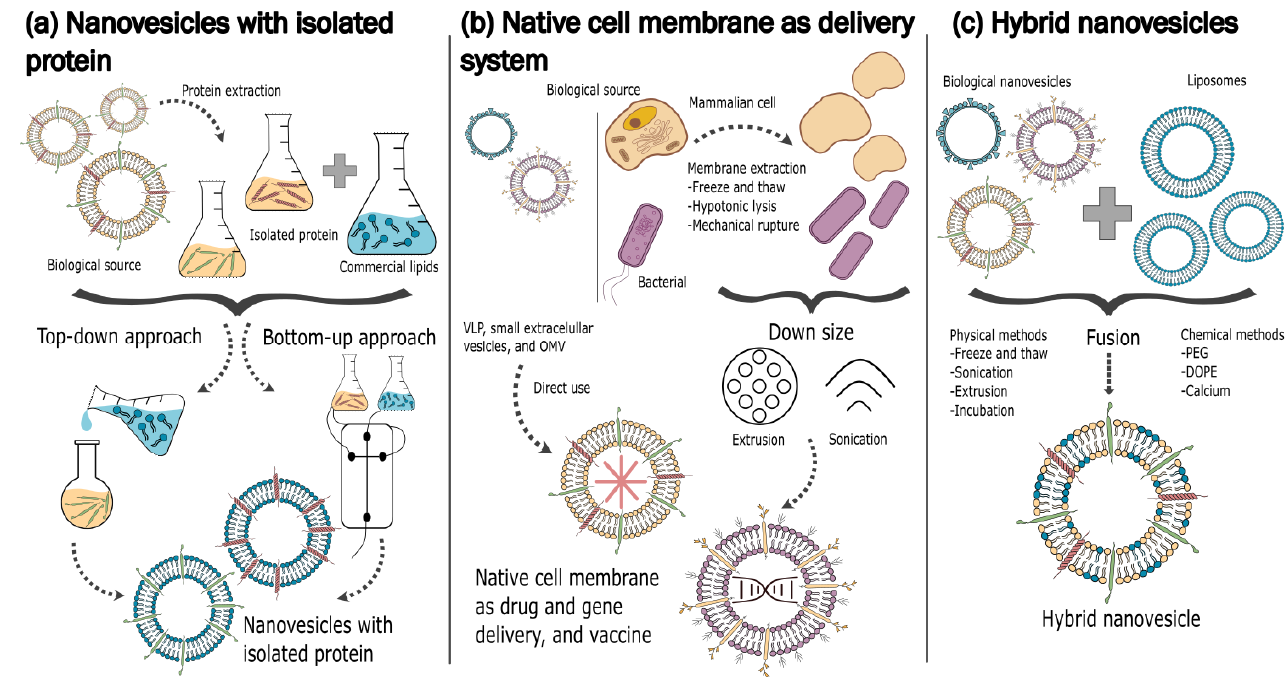
Figure 3. Design strategies for biomimetic vesicles. ( a ) Nanovesicles with isolated proteins are produced by top-down or bottom-up approaches by isolating a specific protein from a biological source and putting it into the lipid bilayer of a nanovesicle to confer a specific function to the delivery system. ( b ) Biological nanovesicles, such as small extracellular vesicles and outer membrane vesicles, can be used directly as drug or gene delivery systems; macrovesicles, such as cell and bacteria ghosts, can be extracted and downsized by extrusion or sonication for use in this application also. ( c ) Hybrid nanovesicles are obtained from the fusion of a biological vesicle and a synthetic liposome by physical or chemical methods in order to increase production